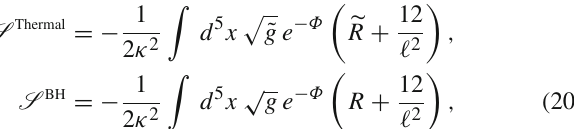
Fig. 3 The numerical results for Δ F as a function of z h for G = 1 (blue line) and G = 50 (red line). We have set C = 1 and κ 2 (cid:7) 2 =